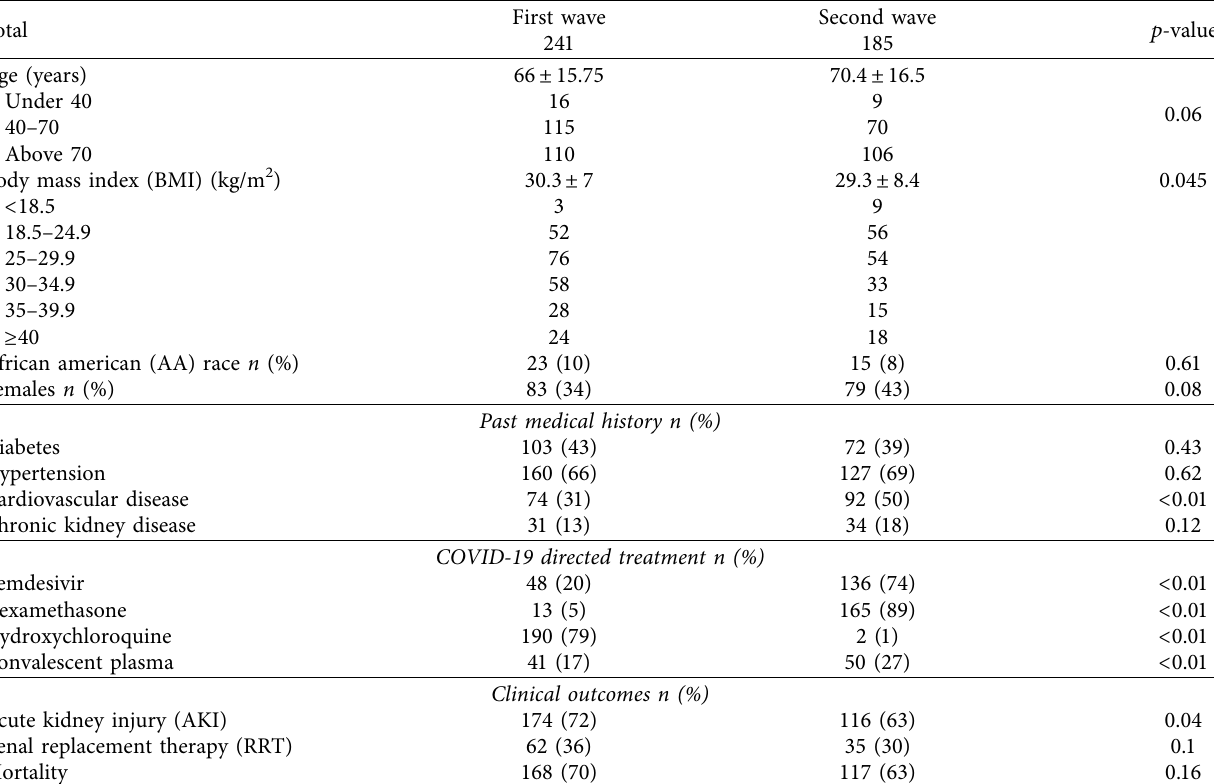
Table 1: Comparison of patient characteristics, treatment, and outcomes between the two